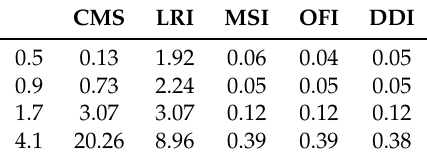
Table A4. Accel.WR in short distance.